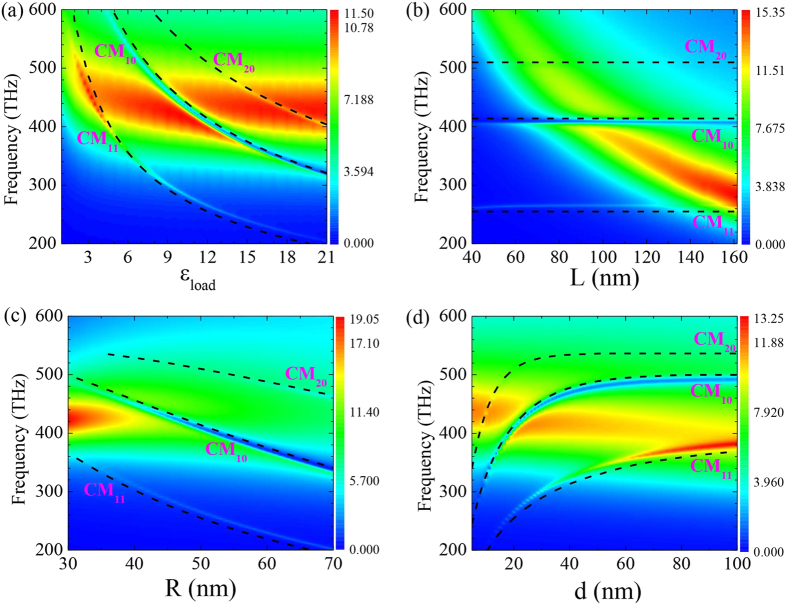
The scattering efficiency (σSCS) contour in the frequency—parameter space.(a) εload from 1 to 21. (b) L from 40 nm to 160 nm. (c) R from 30 nm to 70 nm. (d) d from 5 nm to 100 nm. The default parameter values are the same in Fig. 2. The dashed black lines show the resonance frequency dependence on the respective design parameters, obtained by the theoretical prediction for the CM11, CM10 and CM20 modes.